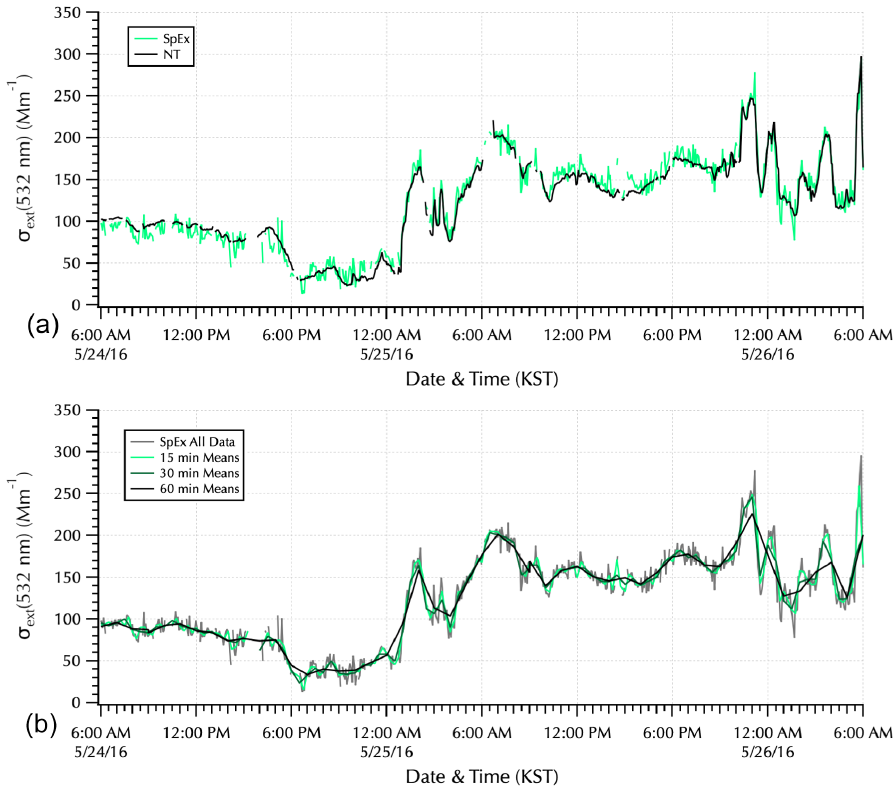
Figure 5. Two day highlight of the top two panels of Fig. 4. (a) σ ext (532nm) from SpEx (green) shown with NT (black). (b) σ ext (532nm) from SpEx (all data, gray) with 15min (light green), 30min (dark green), and 60min (black) means.